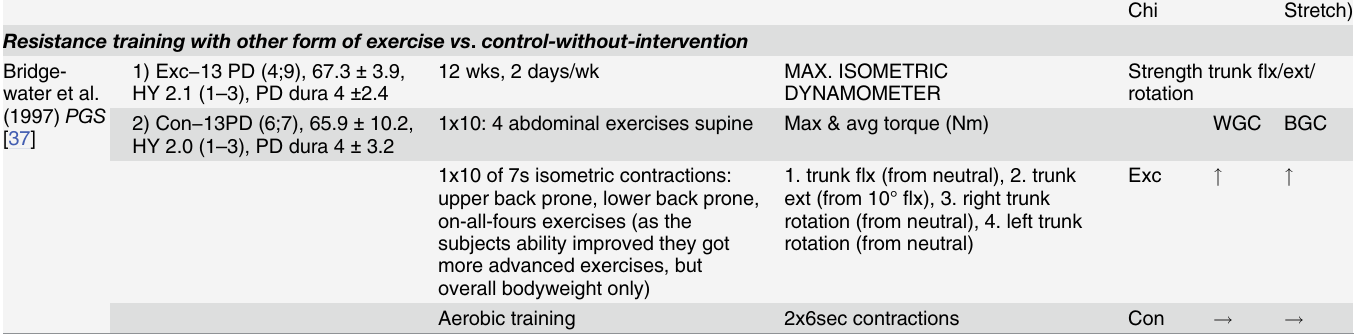
Resistance training with other form of exercise vs . control-without-intervention Bridge- water et